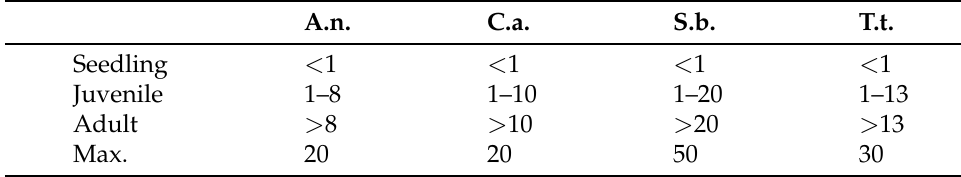
Table A2. Age types classification by stem